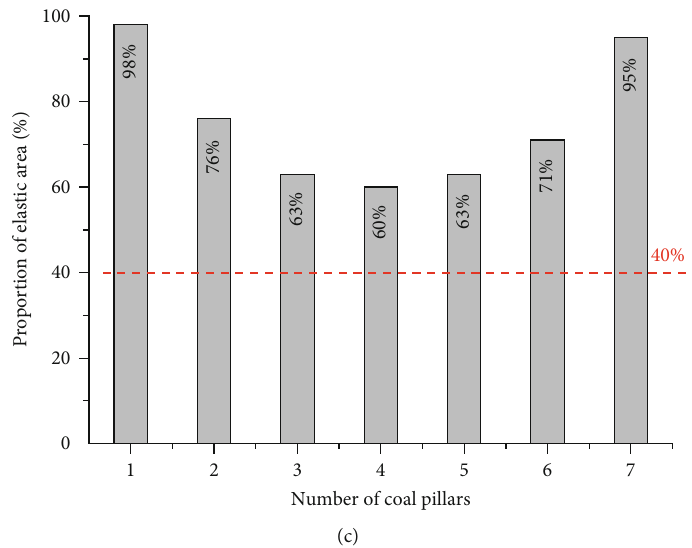
Figure 6: Initial stability of coal pillars below the no. 6107 working face before mining: (a) elastic-plastic regional distribution of the no. 4 coal pillar; (b) heave of the left and right side of the no. 4 coal pillar; (c) proportion of elastic core areas of each coal